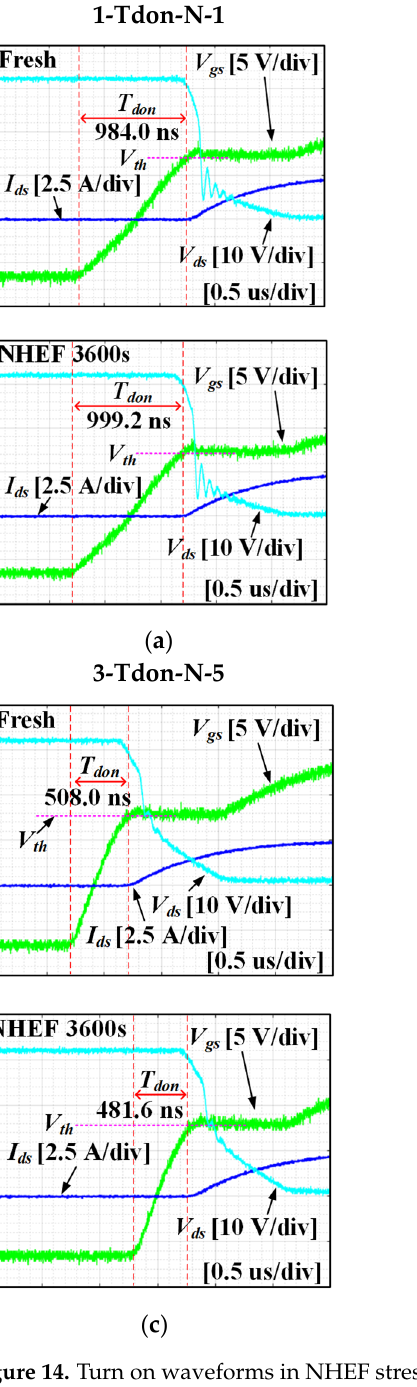
( d ) Figure 15. T don variations in NHEF stress: ( a ) Si IGBT, ( b ) Si MOSFET, ( c ) Si IGBT with SiC diode, and ( d ) SiC MOSFET. 5.2. Turn-Off Delay Variation under HEF Stress Figure 16 shows some of the results of the T doff experiment in PHEF stress. As shown in Figure 16, in the case of 1-Tdoff-P-1, 2-Tdoff-P-2, and 3-Tdoff-P-1, the difference be- tween before and after PHEF stress was not clear. However, T doff of 4-Tdoff-P-4, as shown in Figure 16d, decreased sharply after PHEF stress. The T doff variation of 4-Tdoff-P-4 was − 42%. This reduction in T doff can be explained by a change in V m . Looking at the change in